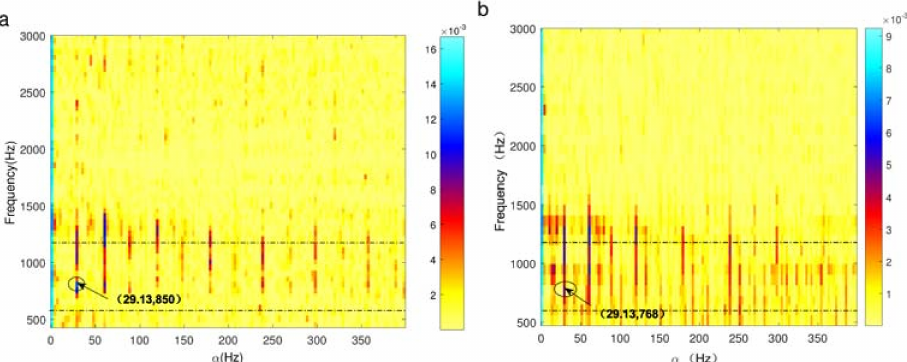
Figure 15. The MID SCoh ∆